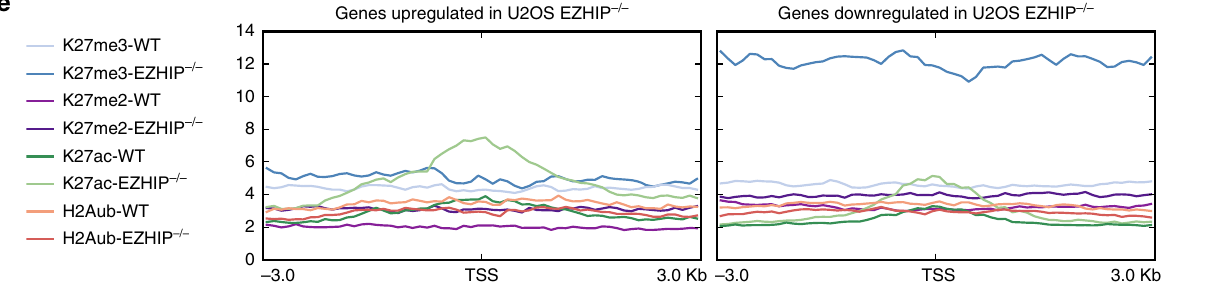
Fig. 3 EZHIP-mediated interplay between H3K27me2 and H3K27me3. a Genome-browser representation of H3K27me3 enrichment in U2OS WT, EED − / − , and EZHIP − / − . Duplicates are merged, same scale for all tracks. b Corresponding Genome-browser representation of H3K27me2, H3K27Ac, and H2AK119ub in U2OS WT and EZHIP − / − . Duplicates are merged. Same scale for all tracks of the same histone modi fi cation. c , d Heatmaps and corresponding cumulative plots showing the enrichment for H3K27me3 ( c ) and, H3K27me2, H3K27Ac, and H2AK119ub ( d ) at the peaks ( n = 34220) found to gain H3K27me3 upon deletion of EZHIP . e Density plots showing the enrichment for H3K27me3, H3K27me2, H3K27ac, and H2Aub around the TSS of genes either upregulated or downregulated upon known out of EZHIP as de fi ned in Fig.